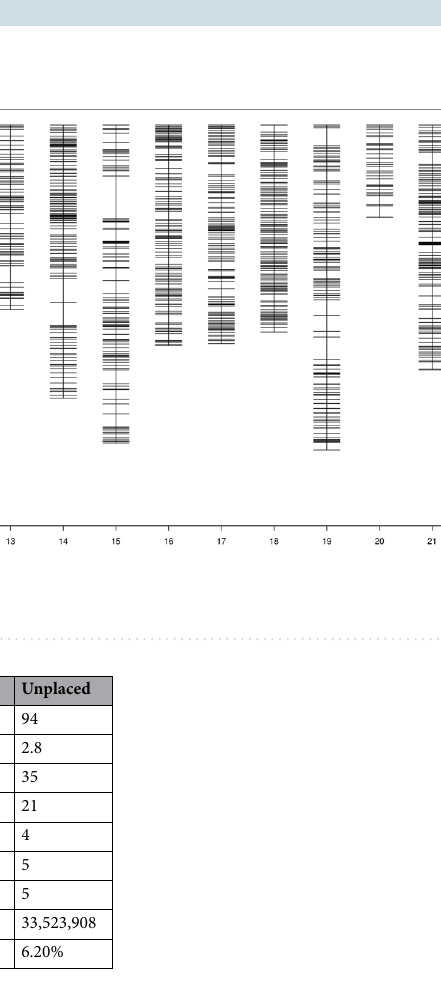
Table 3. Re-anchoring summary information using SLAF-based high density genetic